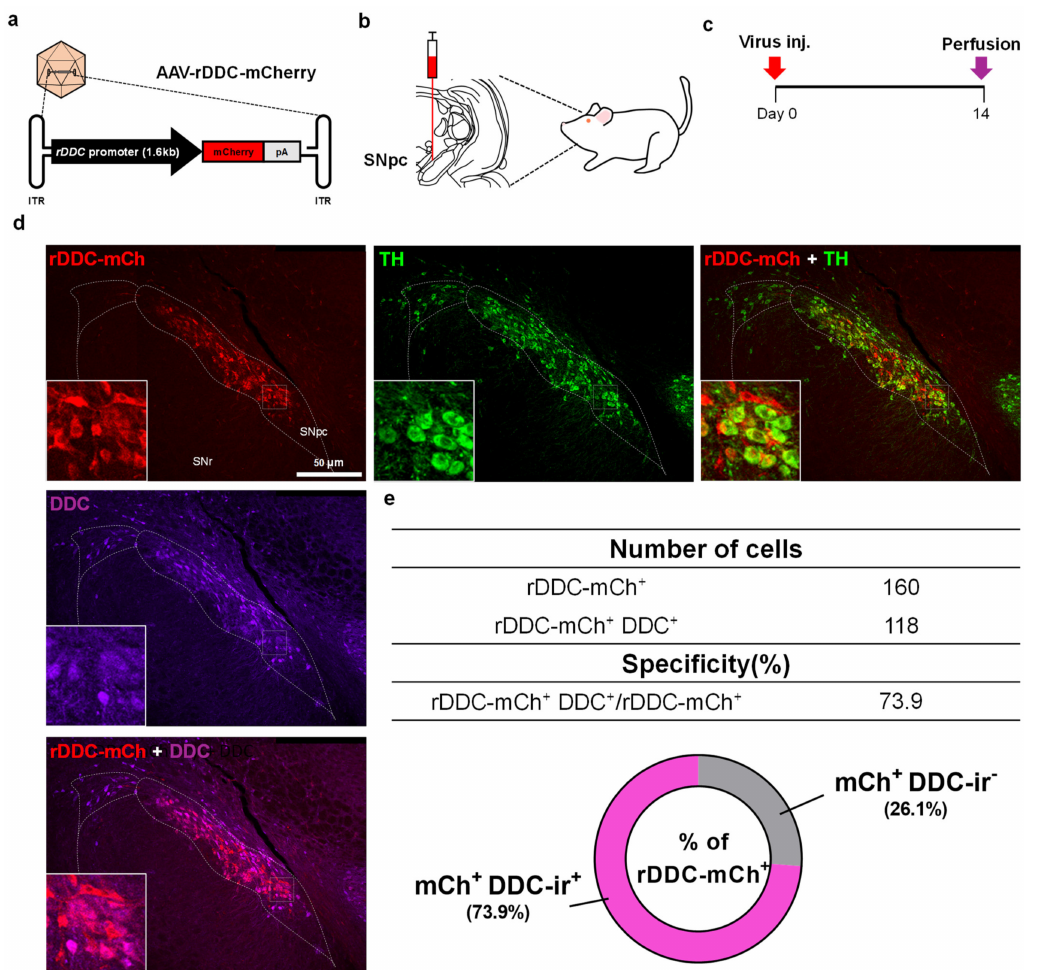
Figure 1. Development and specificity validation of rDDC-promoter. ( a ) Schematic diagram of AAV-rDDC-mCherry virus. Expression of the mCherry is regulated by an upstream rDDC-promoter. The polyadenylation signal (pA) marks the end of the transcriptional cassette. The entire cassette is flanked by ITRs that serve as signals/primers for vector DNA replication and encapsidation. The promoter sequence was referred to as NM_12545, chr14-:91,998,135-91,996,504 (assembly version rn6); ( b ) schematic diagram of stereotaxic virus injection into SNpc; ( c ) experimental timeline; ( d ) representative confocal images of SNpc, which was injected with AAV-rDDC-mCherry and immunolabeled with anti-TH and anti-DDC antibodies. Scale bar = 50 µ m; ( e ) top, number of cells expressing mCherry and/or DDC. Bottom, quantification of the specificity of mCherry + /DDC + neurons out of whole mCherry + neurons in SNpc ( n = 4